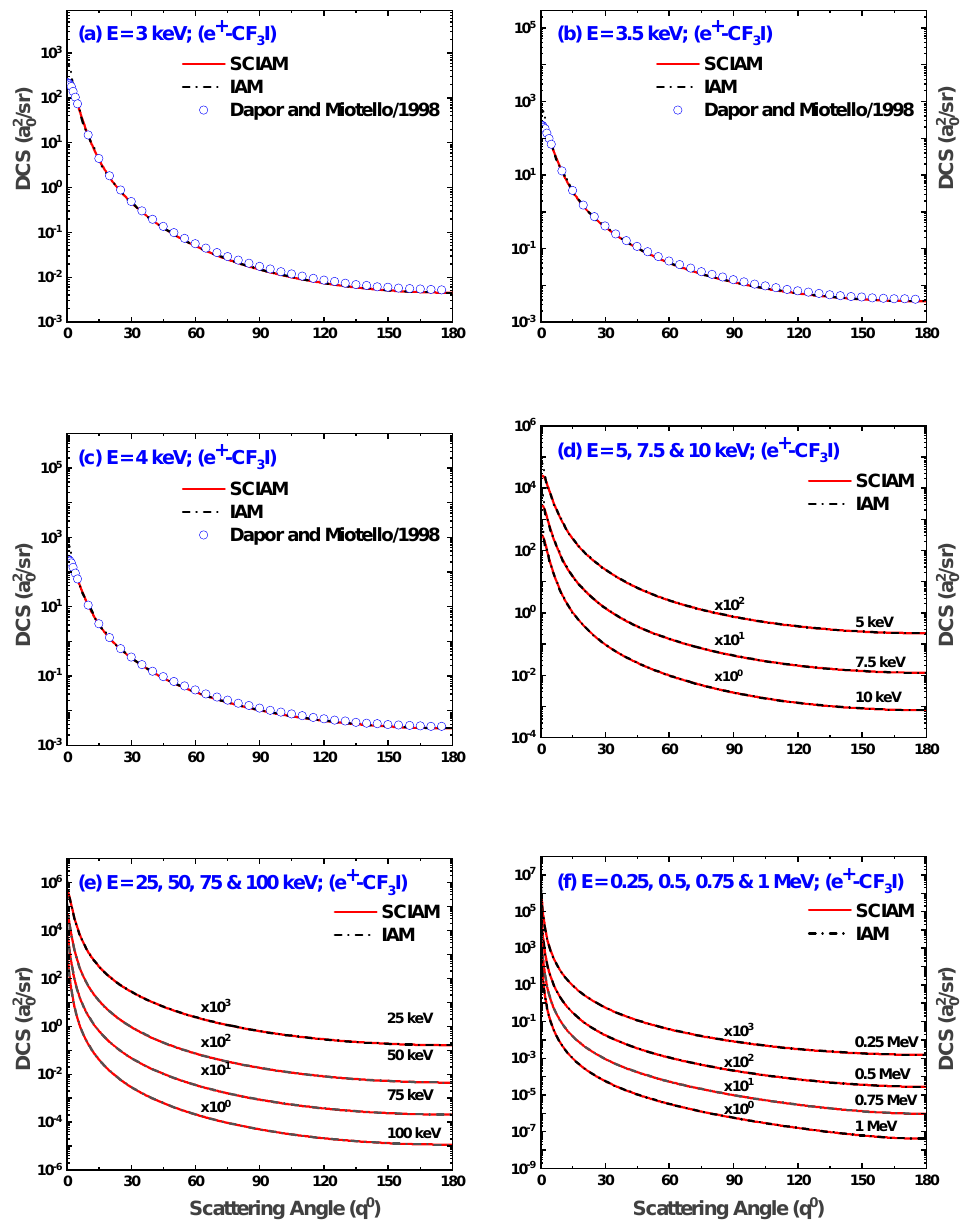
Figure 5. DCS ( a 2 / sr ) for the elastic scattering of positrons from CF 3 I at incident energies 3, 3.5, 4, 5, 0 7.5, 10, 25, 50, 75, 100, 250, 500, 750, and 1000 keV. Theoretical works: SCIAM, IAM, and Dapor and Miotello